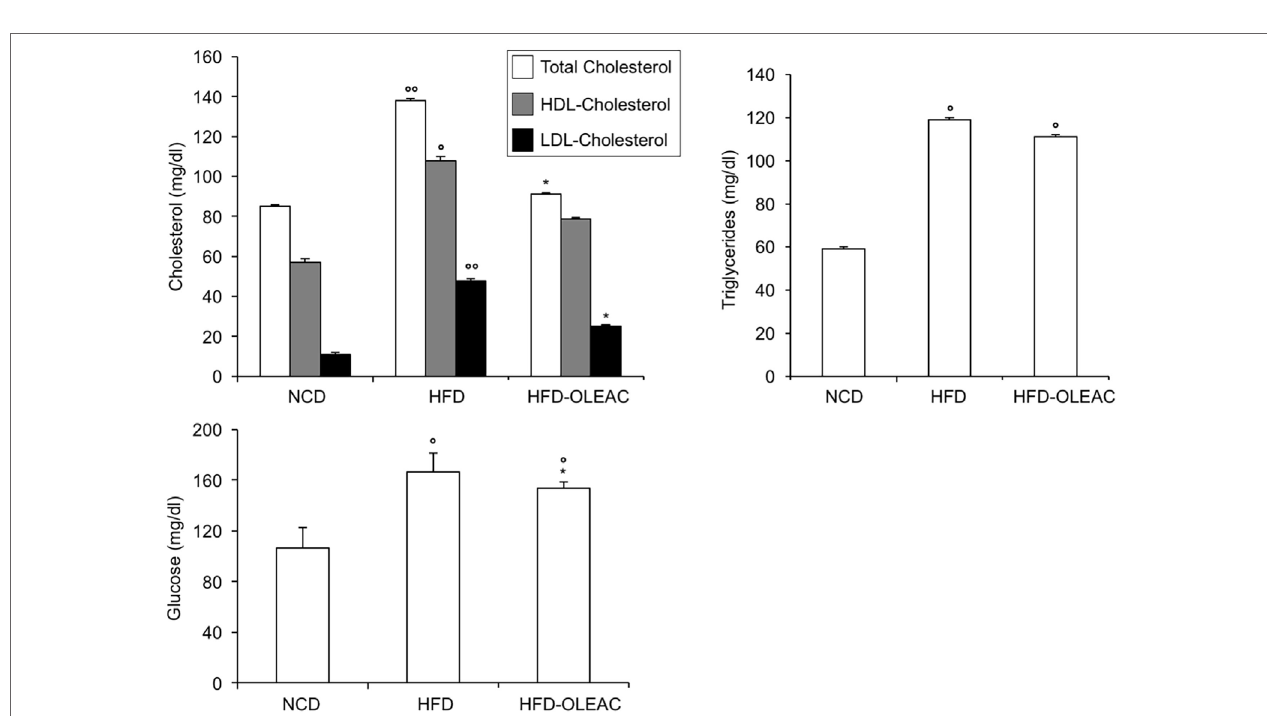
FigUre 7 | Effects of oleacein on lipid serum levels in obese mice fed with high-fat diet (HFD). Blood samples were collected as indicated in the Section “Materials and Methods.” After 13 weeks of feeding with HFD, total cholesterol, high-density lipoprotein cholesterol (HDL-C), and low-density lipoprotein cholesterol (LDL-C) were measured together with triglyceride and plasma glucose levels. Values are expressed as mean ± SD. * p < 0.001 vs mice fed with HFD. ° p < 0.05, °° p < 0.01 vs mice fed with